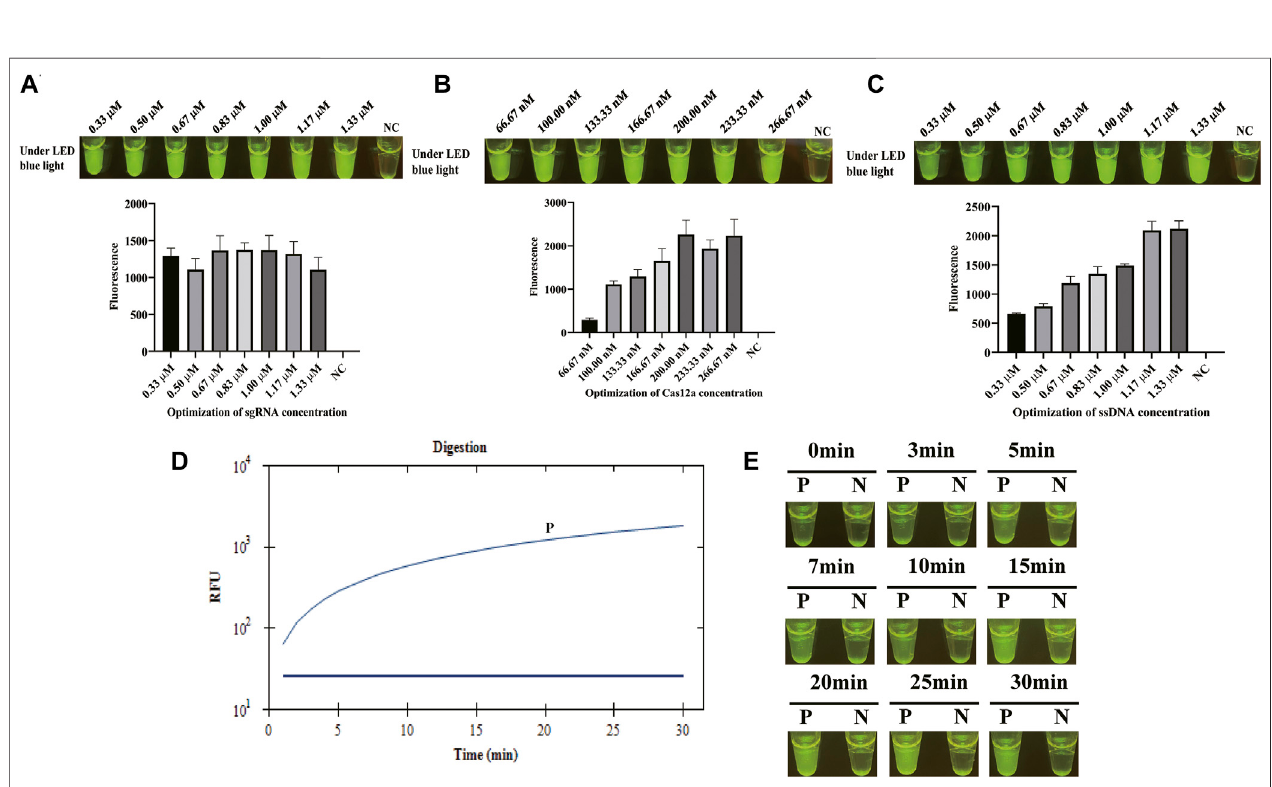
FIGURE 3 | Optimization of CRISPR/Cas12a-E-LAMP method. S. fl exneri -recombined plasmids (4*10 3 copies/ μ l) were used in the optimization of CRISPR/ Cas12a-E-LAMP method byendpoint fl uorescence photography and endpoint fl uorescence intensity. (A) Optimization of the concentration of sgRNA. (B) Optimization of the concentration of Cas12a. (C) Optimization of the concentration of ssDNA-FQ probe. (D,E) The time optimization of CRISPR/Cas12a-E-LAMP.